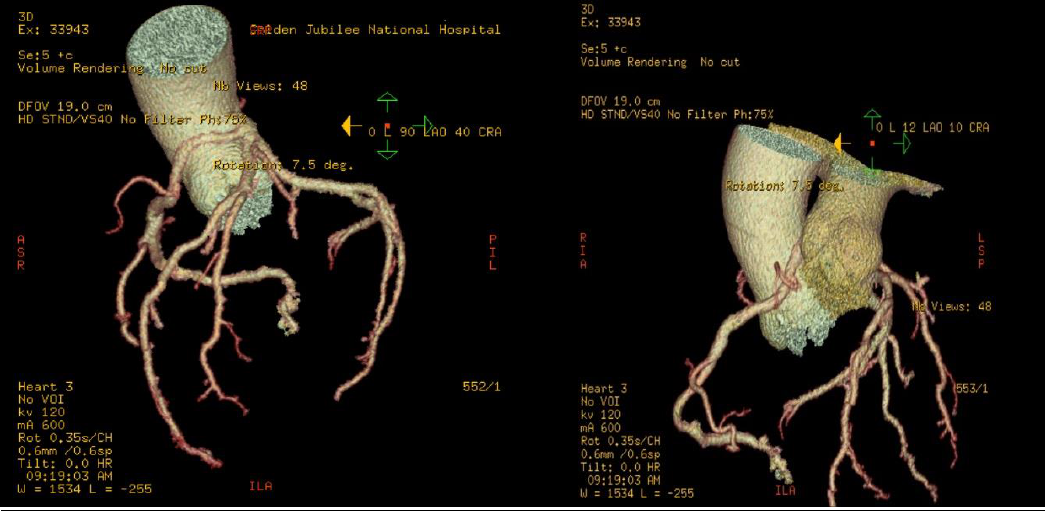
Figure 2. Pie Chart showing coronary artery morphology among patients. AAOCA — Anomalous aortic origin of coronary artery, RCA — right coronary artery, LCC — left coronary cusp, LMS — left main stem, LCA — left coronary artery, RCC — right coronary cusp.